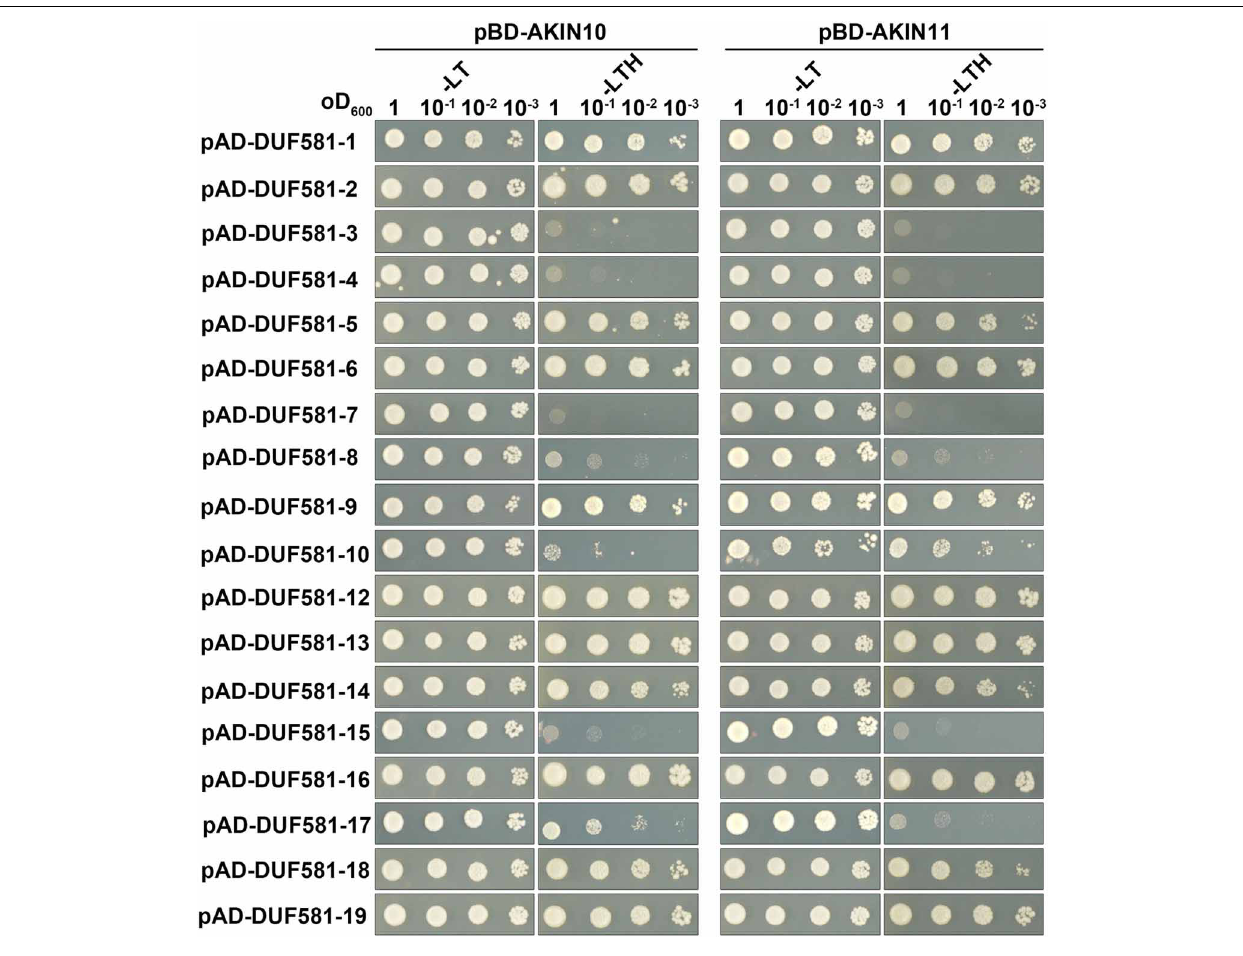
Cells were grown on selective media for 3 days at 30 ◦ C before the pictures were taken. –LT, yeast growth on medium without Leu and Trp. –LTH, yeast growth on medium lacking Trp, Leu, and His, indicating expression of the HIS3 reporter